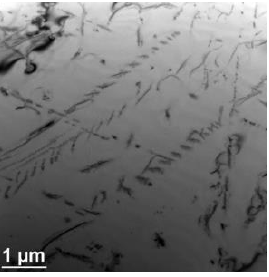
Figure 8. Z-phase aggregation precipitates inside the austenite grain.